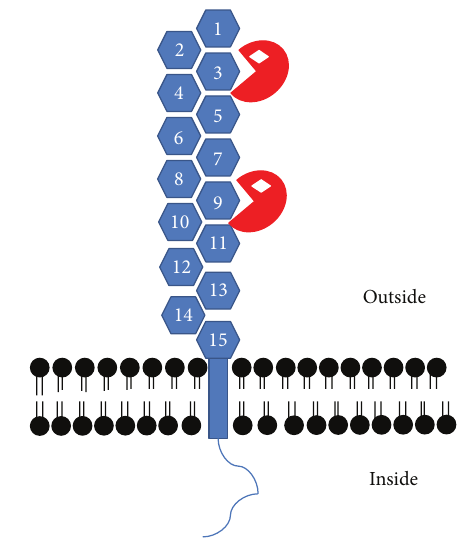
Figure 3: Structure of the IGFII/M6P receptor. The receptor has a cytoplasmic tail that triggers receptor internalization and signalling, a small transmembrane domain, and a large extracellular domain with 15 repeating segments. Mannose-6-phosphate labelled ligands (red symbol with white box for mannose-6-phosphate) bind to repeatingsegments3and9.Unlikethisschematicoverviewthemost likely appearance of this receptor in living cells is that of a